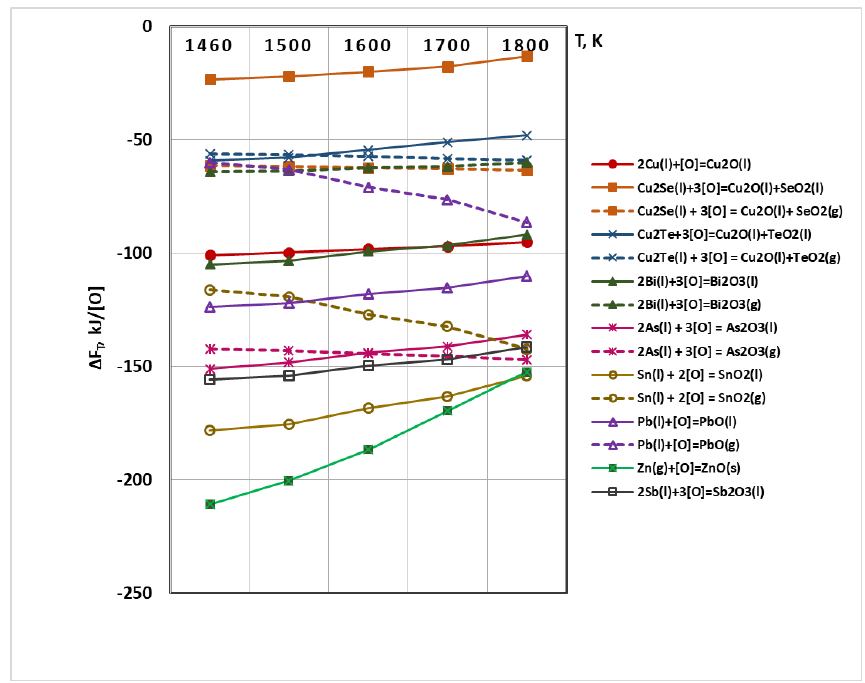
Figure 3. Influence of the temperature on ΔF T of oxidation reactions of Cu(l) and R i (l,g) under vacuum conditions.